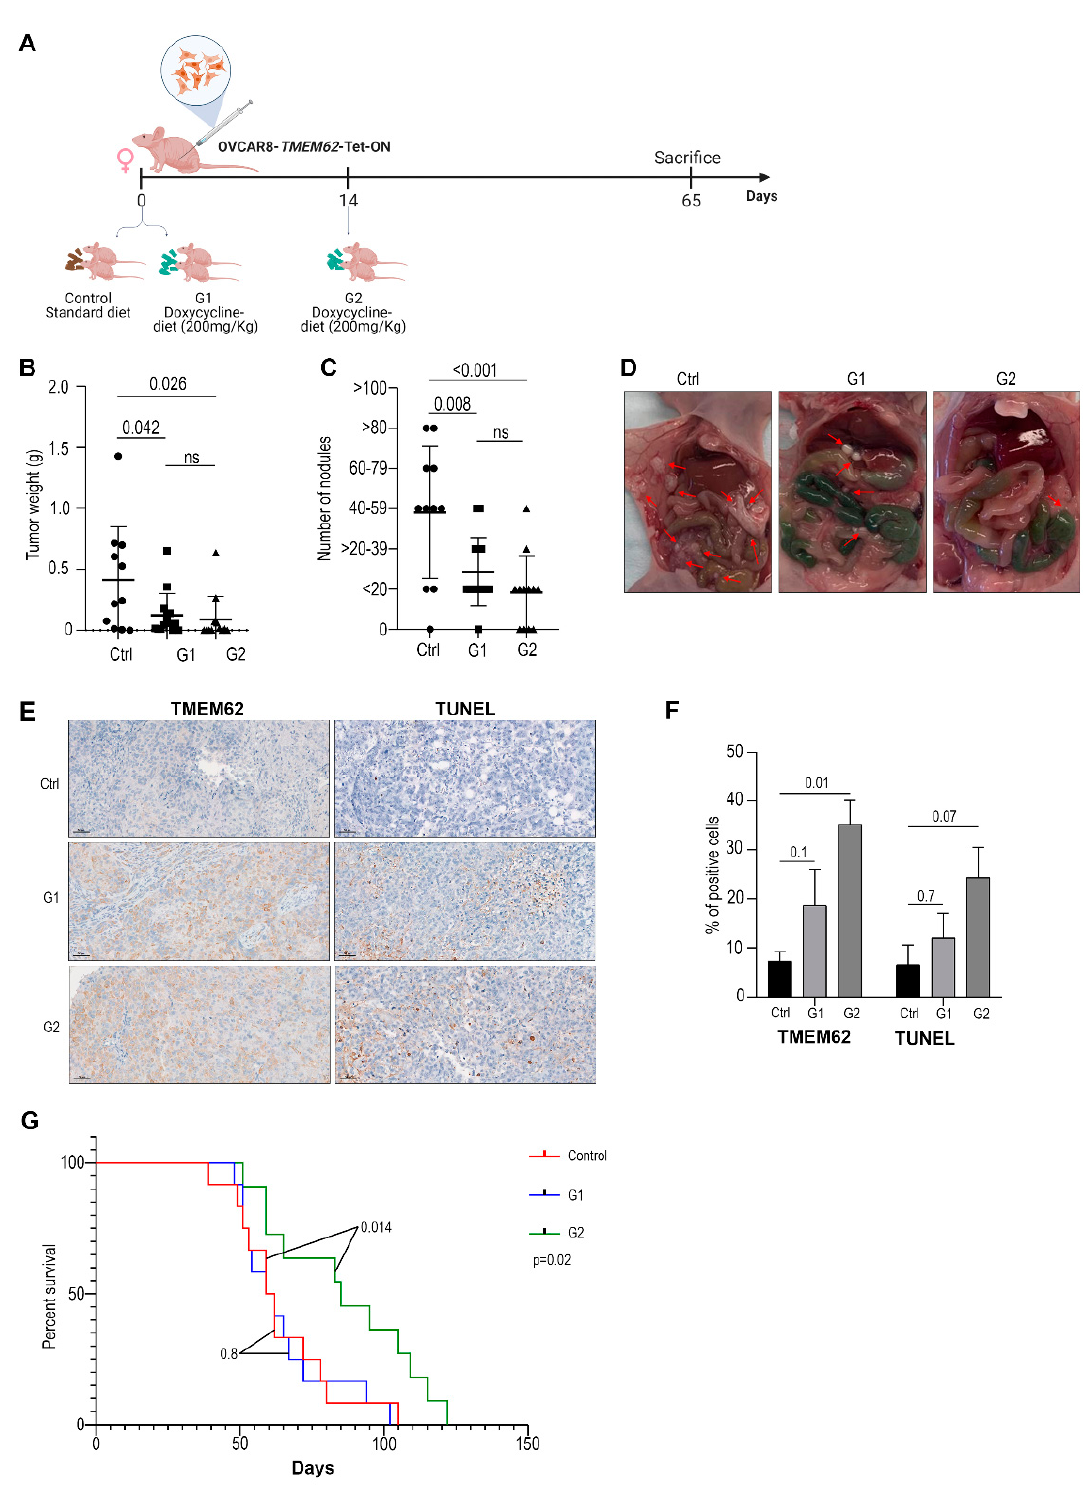
Figure 3. In vivo data generated by injecting OVCAR8- TMEM62 -TetOn cells. ( A ) Representative schema of cell injection and groups included in the study. ( B ) Tumor weight and ( C ) number of tumor nodules. ( D ) Representative images of tumors in each group. Red arrows indicate the location of tumor nodules. ( E ) Representative images of TMEM62 expression (left panel) and TUNEL assay (right panel). Scale: 50 µ m ( F ) Quantification of TMEM62 and TUNEL assay. ( G ) Survival experiment in OVCAR8- TMEM62 -TetOn model.